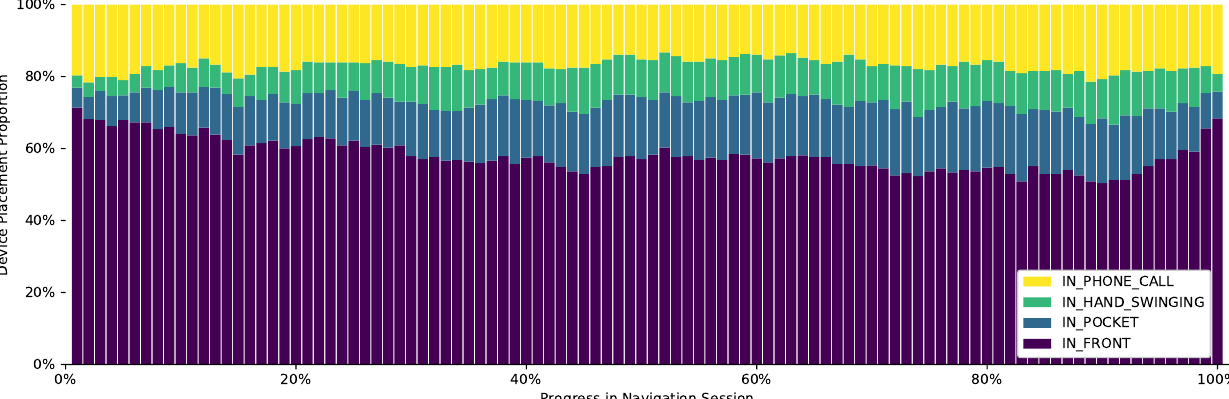
Figure 12. Distribution of device placement over the time of a navigation session.